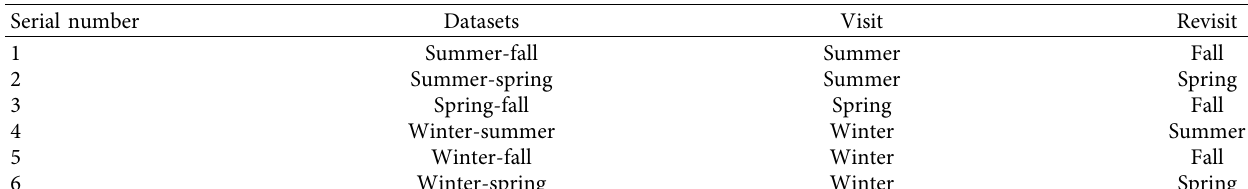
Table 4: Experimental datasets.